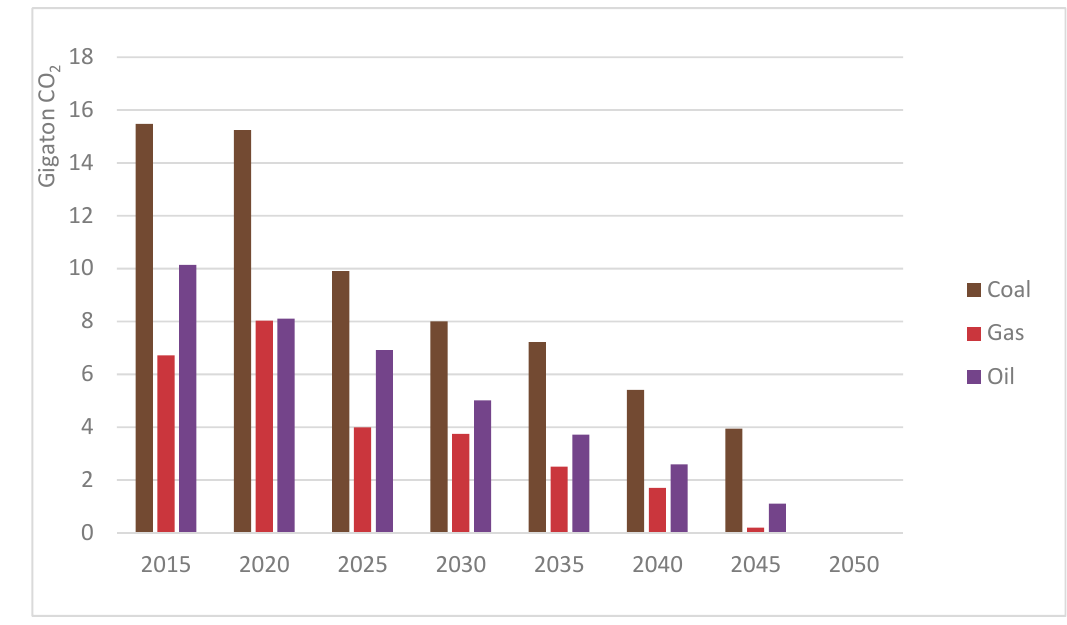
Figure 11. Global emissions per fossil energy carrier in billion tons.